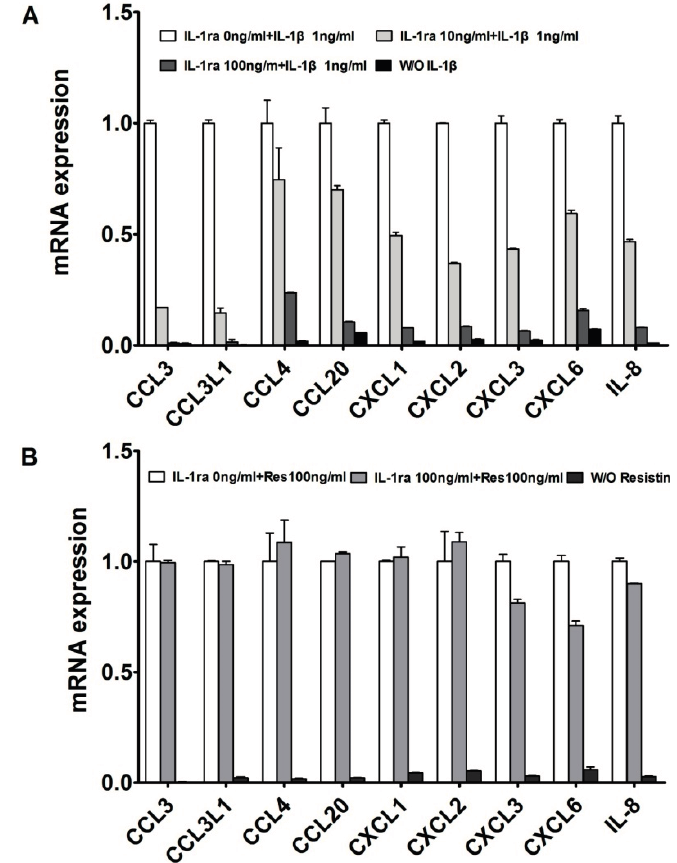
Figure 1. Resistin independently stimulates the expression of chemokines in normal human articular chondrocytes (HACs). ( A ) HACs were treated with 1 ng/mL IL-1 β with various doses of IL-1ra for 24 h, as indicated. W/O IL-1 β means blank control without IL-1 β ; ( B ) HACs were treated with 100 ng/mL resistin with or without IL-1ra for 24 h, as indicated. W/O resistin means blank control without resistin . The relative expression levels were examined by quantitative real time PCR method. Each bar represents the mean ± S.D. from three experiments. W/O resistin means blank control without resistin